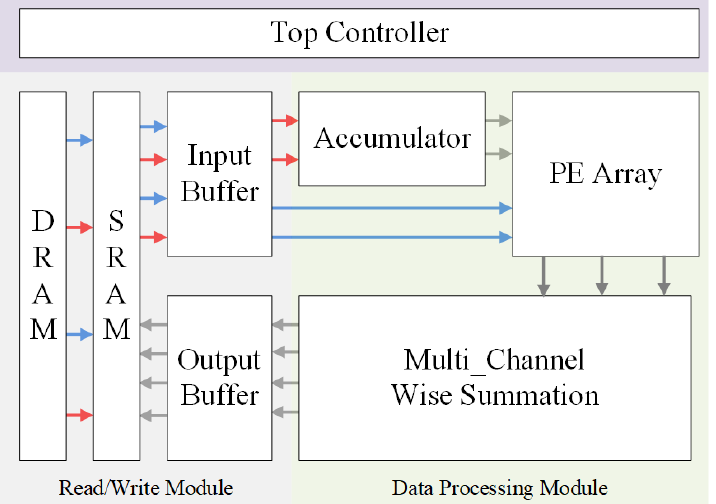
Figure 6. Hardware architecture: The red and blue arrows correspond to the data flow of the input images and